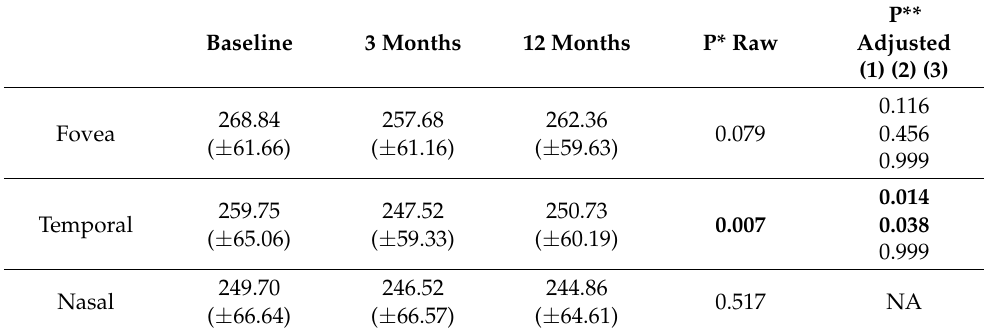
Table 5. Choroidal thickness recorded at baseline and at 3 and 12 months of follow up in patients with obstructive sleep apnea undergoing continuous positive airway pressure